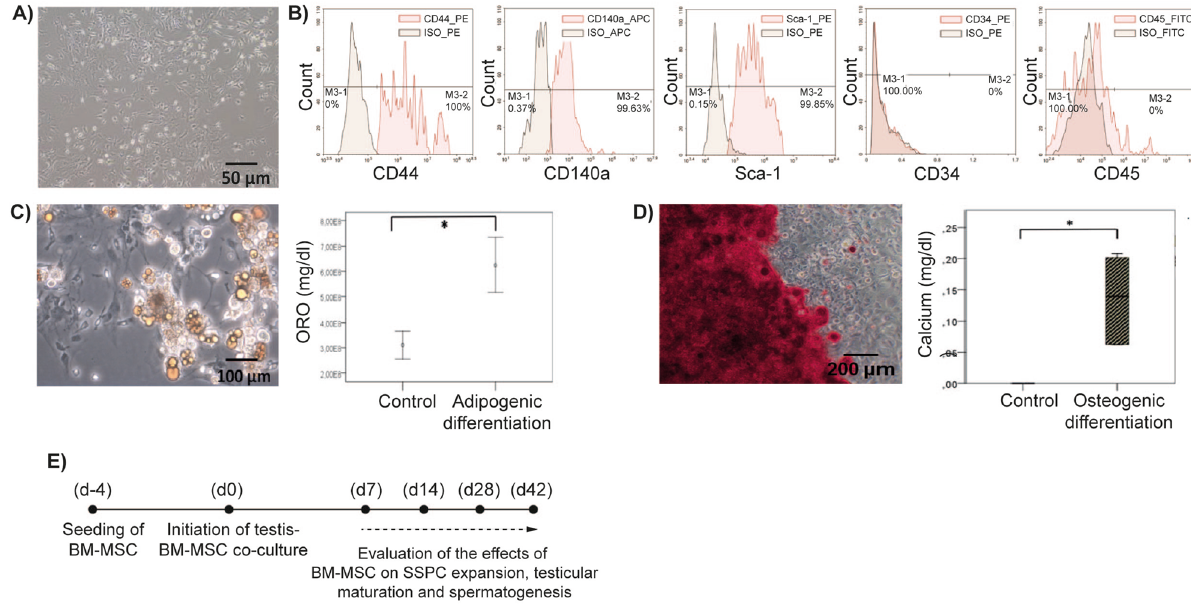
Figure 2. Characterization and workflow for BM-MSCs. ( A ) Micrograph of passage 3 spindle shaped BM-MSCs adhere to culture plate (100x). ( B ) FCM analysis of BM-MSCs expressing MSC surface markers (CD44, CD140a, Sca-1) positively and hematopoietic markers (CD34, CD45) negatively. BM-MSCs presents ( C ) adipogenic and ( D ) osteogenic differentiation (ORO, 200x; ARS, 100x, respectively, * p < 0.01). ( E ) Four day before the experiment, the MSCs were seeded into the wells and the insertion of testicular strips to the culture systems in both control and co-culture plates are accepted as day